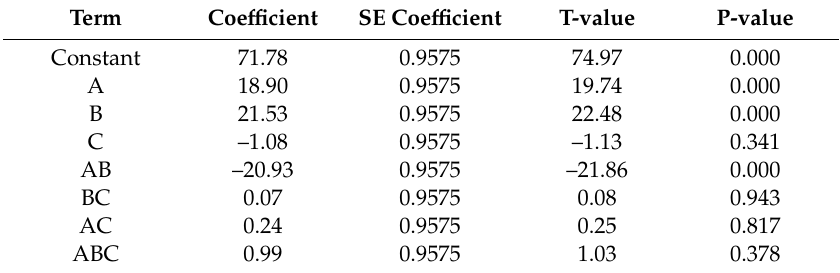
Table 2. ANOVA analysis for the fractional factorial design carried out to determine the factors that have significant e ff ect on the decolorization e ffi ciency (D.E. (%)).